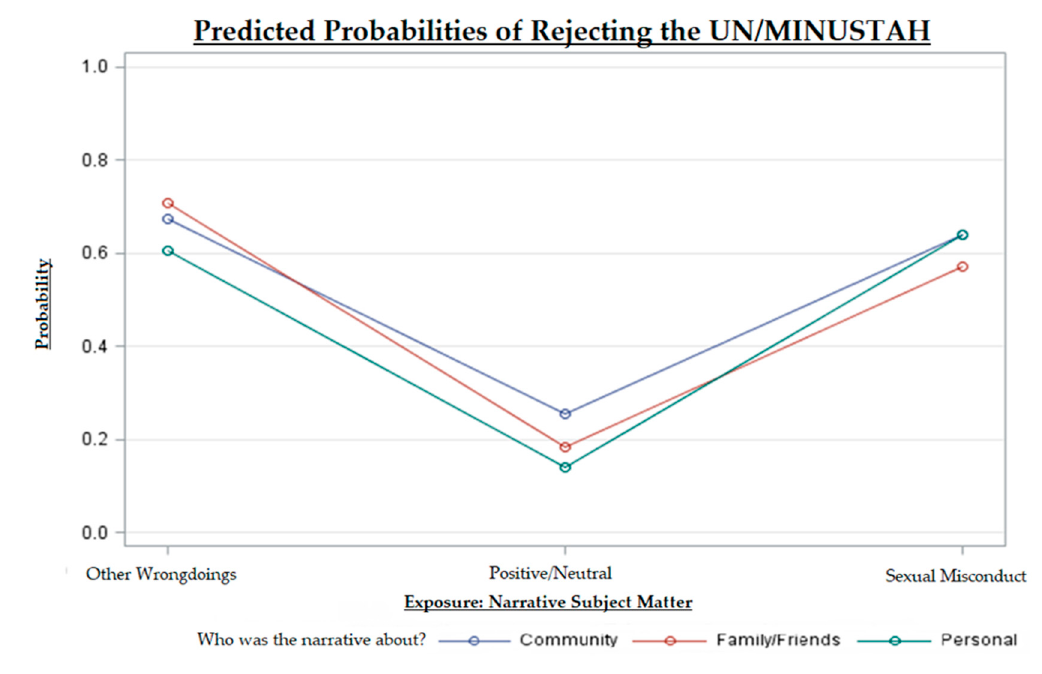
Figure 3. Interaction plot of narrative subject and predicted probability of rejecting the UN/MINUSTAH, stratified by who the narrative is about *. Table 5. Association between narrative subject matter and the probability of rejecting the UN/MINUSTAH stratified by who the narrative is about.